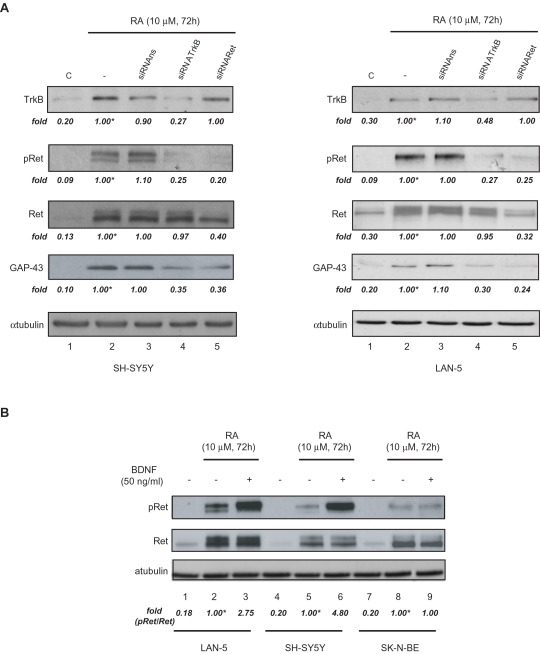
Existence of a cross-talk between TrkB and Ret in SH-SY5Y and LAN-5 cells.(A) RA-treated SH-SY5Y (left panels) and LAN-5 (right panels) cells were transfected with siRNATrkB (lane 4), siRNARet (lane 5) or negative control siRNAns (lane 3). C is referred to untreated cells (lane 1). Cell lysates were immunoblotted with anti-TrkB, anti-pRet, anti-Ret, or anti-GAP-43 antibodies, as indicated. The equal protein loading has been confirmed by immunoblotting with anti-atubulin? antibodies. (B) RA-treated LAN5, SH-SY5Y and SK-N-BE cells were left un-treated (lanes 2, 5 and 8, respectively) or treated with BDNF (lanes 3, 6 and 9, respectively). Lanes 1, 4 and 7 are mock-treated cells. Cell lysates were immunoblotted with anti-pRet or anti-Ret antibodies. To confirm equal loading the filters were stripped and reprobed with anti-αtubulin? antibodies. In (A) and (B), quantitation and relative abundances are expressed relative to controls, arbitrarily set to 1 (see legend to Figure 1A). Blots shown in (A) and (B) are representative of at least three independent experiments.